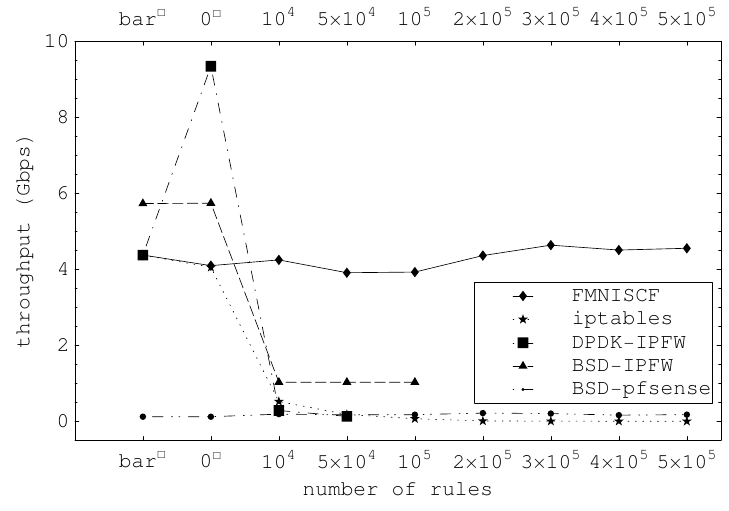
Figure 10. Packet throughput of Iptables and